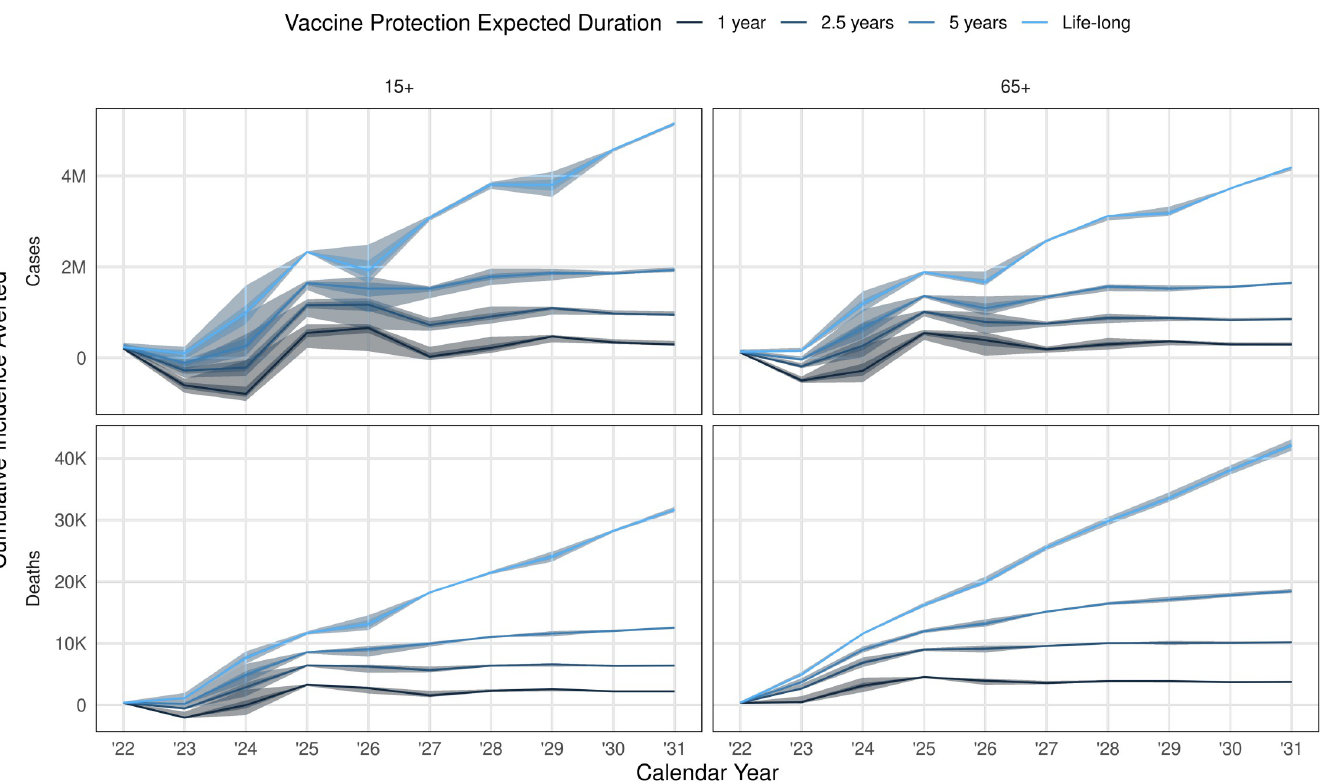
Fig 3. Cumulative cases and deaths averted by the end of each year. For a vaccine efficacy of 70%, delivered in a 2-dose schedule over a 1-year vaccine campaign, and expected duration of infection-derived immunity assumed to be 2.5 years, the median averted disease (lines; darker ribbon 50% IQR, lighter ribbon 95% IQR) with varying vaccine protection duration (from dark to light, increasing vaccine protection duration) and initial target age group (either 15+ or 65+; after the first quarter of vaccination, 15+ is targeted in both cases); other scenarios and health outcomes in Figs D and E in S1